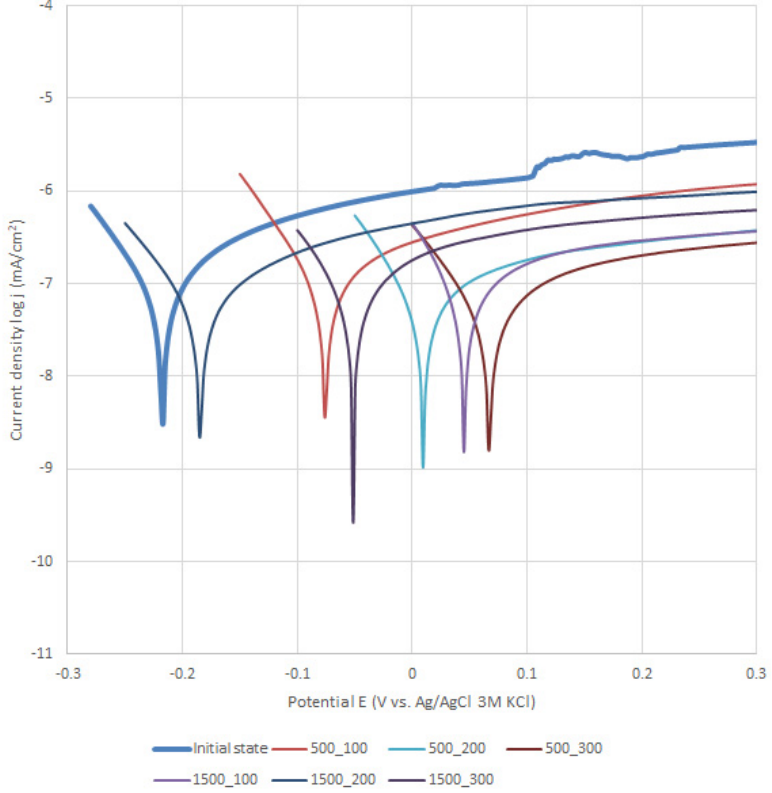
Figure 6. Electropolishing–polarization curves regarding 316LVM with a ZnO layer.